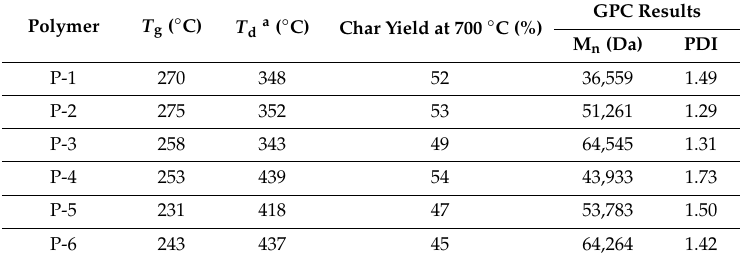
Table 1. Thermal properties and gel permeation chromatography (GPC) data of ionic polymers P-1 to P-6.